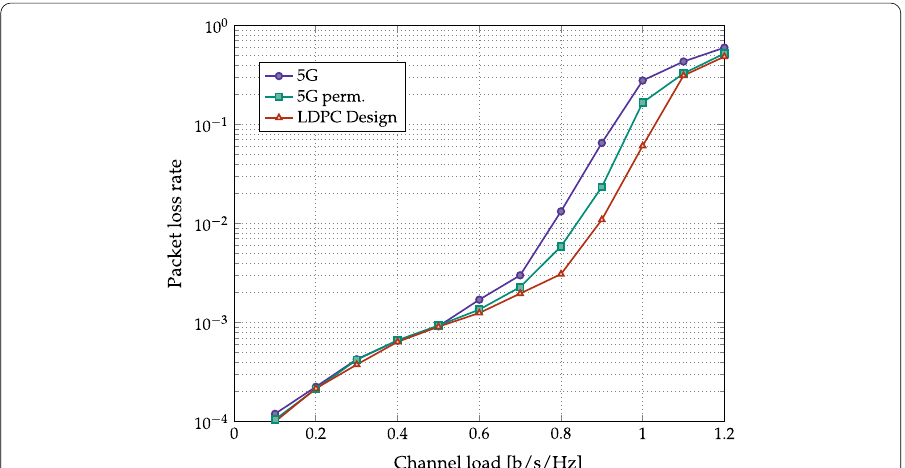
Fig. 4 Slot‑asynchronous random access schemes performance. Slot‑asynchronous random access schemes adopting time diversity, i.e. copies of the same physical layer packet are transmitted with random delays, and interference cancellation. It is shown that a dedicated low‑density parity check (LDPC) code design outperforms standardized 5G error correcting codes. Details on the modern random access scheme and the code design can be found in [67, 68]